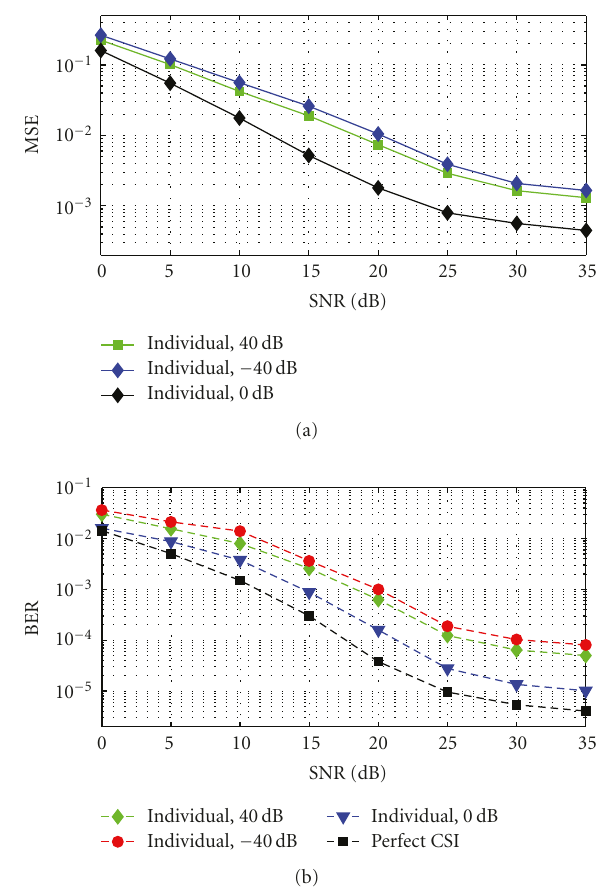
Figure 2: Performance of the individual channel estimation approach. (a) MSE versus SNR, (b) BER performance versus